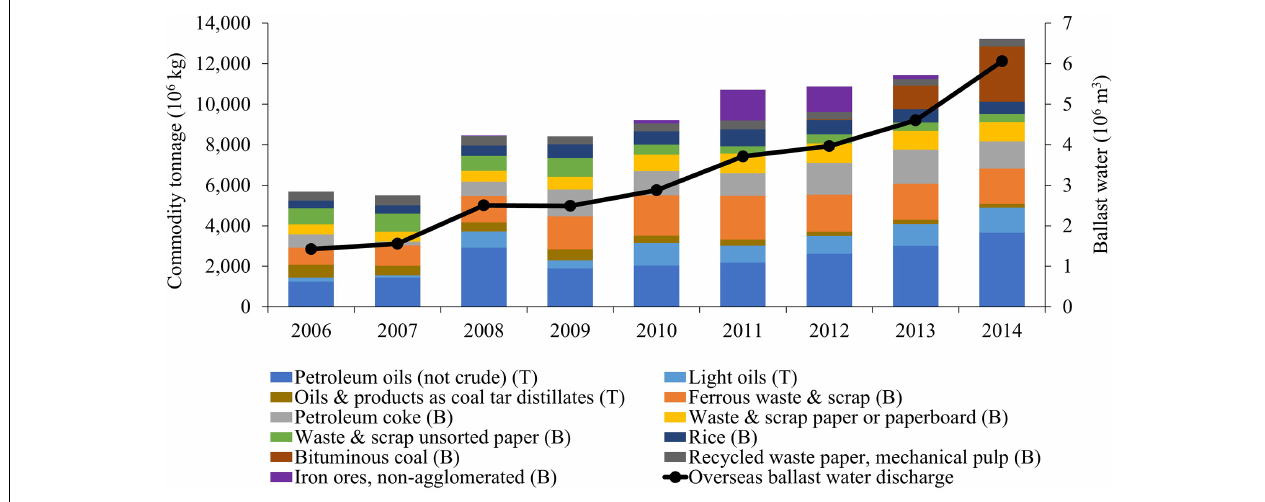
FIGURE 5 | The annual tonnage (bars) of the top eleven commodities exported from San Francisco Bay and the annual volume (line) of overseas ballast water discharge. The type of vessel that exported each commodity is noted as bulk carrier (B) or tanker (T). These top 11 commodities comprised 59% of the total export